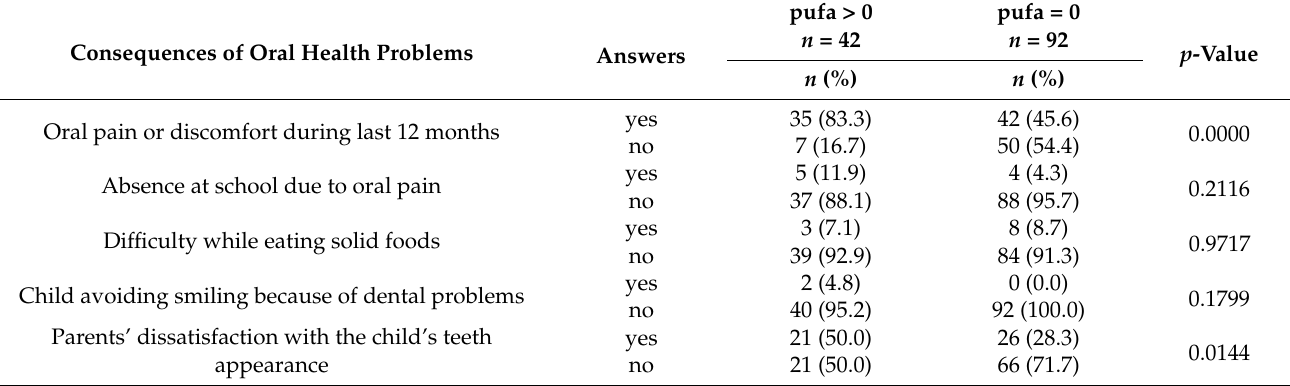
Table 5. Numbers and percentages of subjects reporting oral pain or discomfort, absence at school due to oral pain, difficulty while eating solid foods, problems with smiling, parents’ dissatisfaction with the child’s teeth appearance according to the presence of severely decayed teeth with visible pulpal involvement, ulceration, or abscess (pufa).